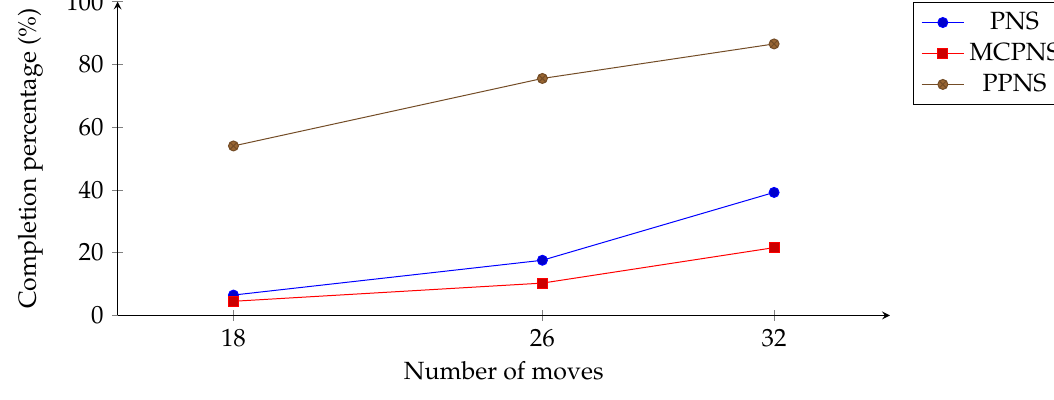
Figure 7. The completion percentage of PNS, MCPNS, and PPNS for different numbers of moves.